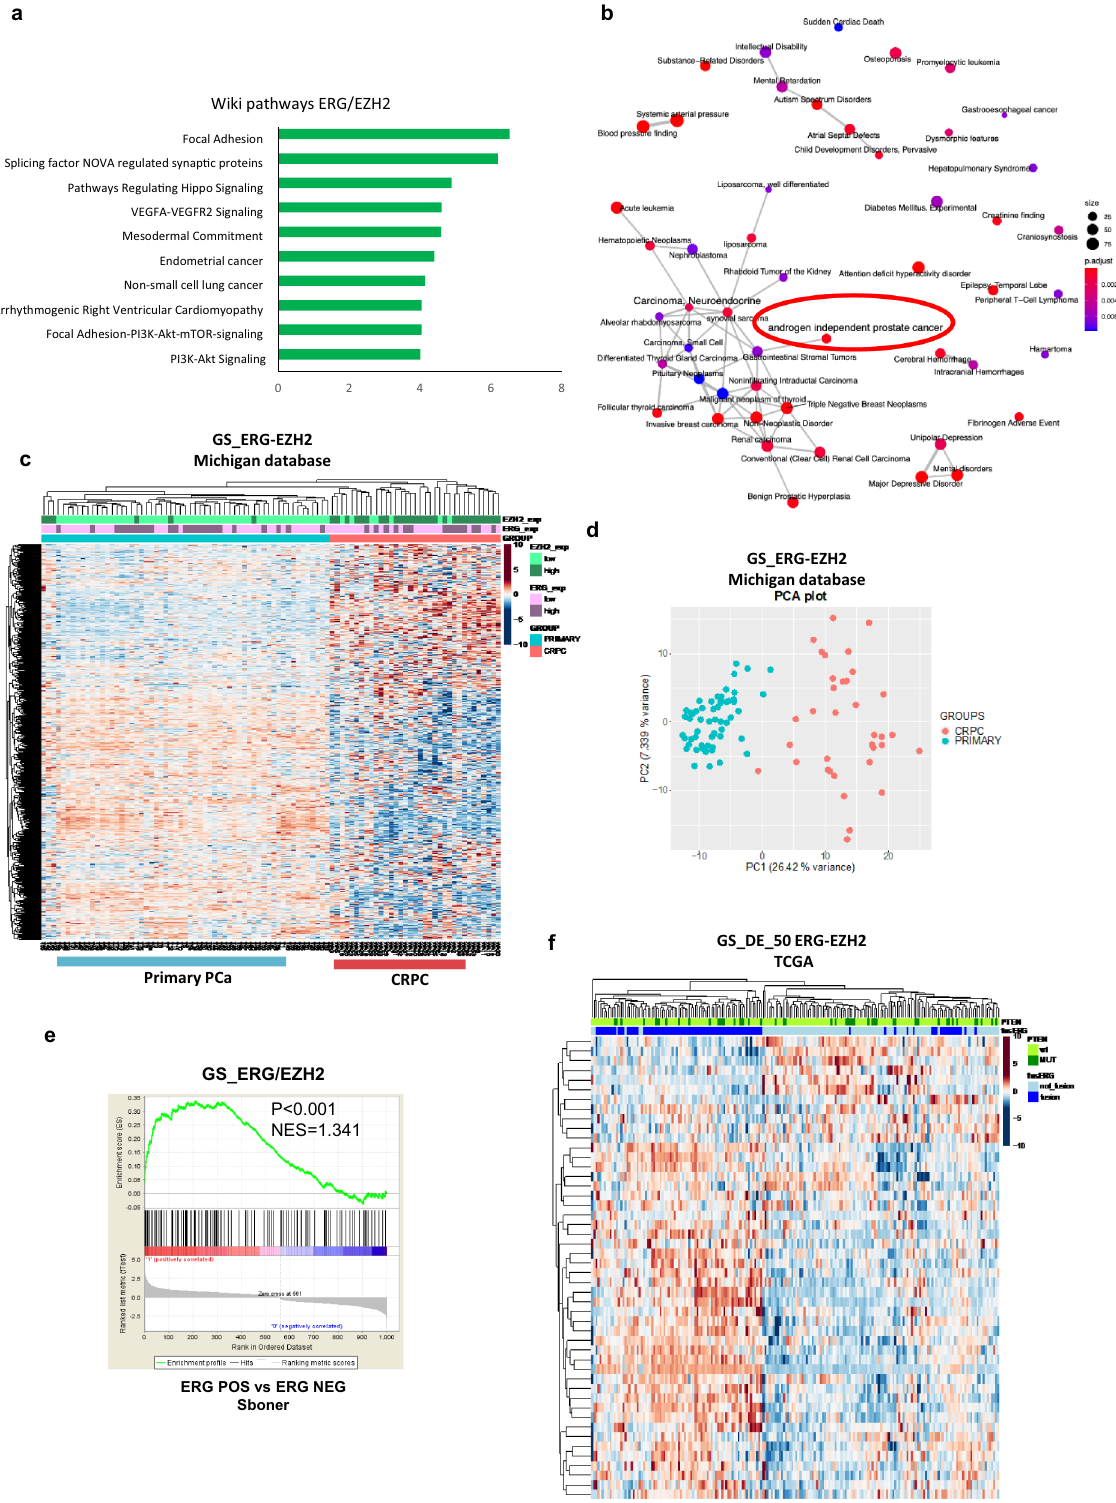
Fig. 8 ERG/EZH2 co-regulated genes are expressed in aggressive prostate tumors. a Pathways enriched in the list of genes co-occupied by ERG/EZH2 (GS_ERG/EZH2, n = 1656 genes) using enrich tool. b Functional analysis of the GS_ERG/EZH2 set using enrichDGN tool. c , d Heat map ( c ) and principal component analysis ( d ) using the GS_ERG/EZH2 set applied to primary prostate tumors (PRIMARY) and castration-resistant prostate cancers (CRPC) with known ERG and EZH2 status in the Michigan dataset. Color bars indicate ERG and EZH2 expression status. e GSEA using the GS_ERG/EZH2 set comparing ERG fusion positive and negative prostate tumors in the Sboner dataset. f Heat map with the top deregulated ERG/EZH2 gene signature (GS_ERG/EZH2_50) applied to the TCGA dataset. Color bars indicate ERG fusion and PTEN